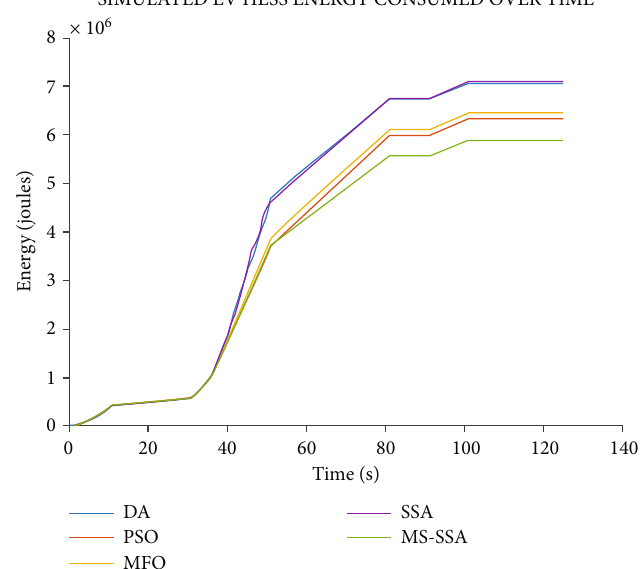
Figure 8: Energy consumption against